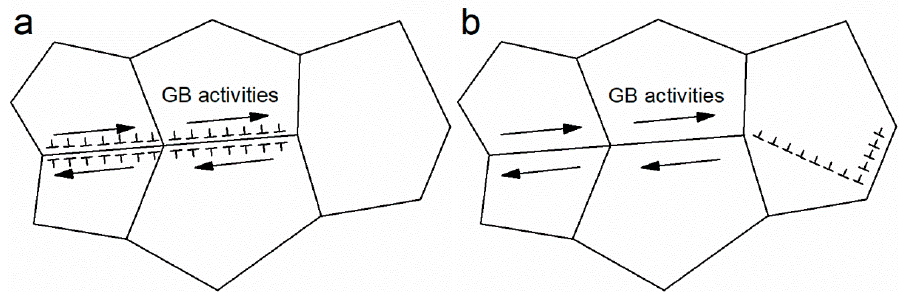
Figure 10. Principles of two models for dislocation sliding in superplasticity: ( a ) Dislocations move along the grain boundary; ( b ) dislocations are produced and move in the blocking grain. Arrows in the graphs presents the grain boundaries (GBs) actives.